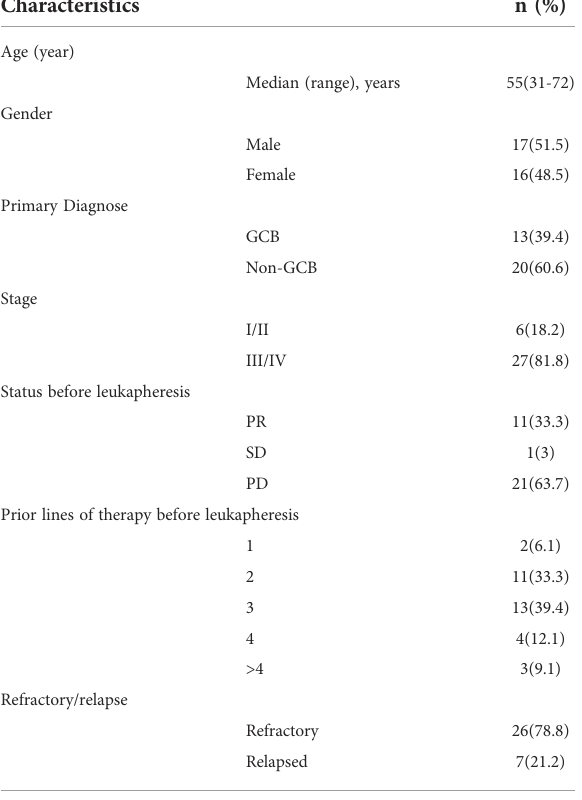
TABLE 1 Baseline characteristics of patients.